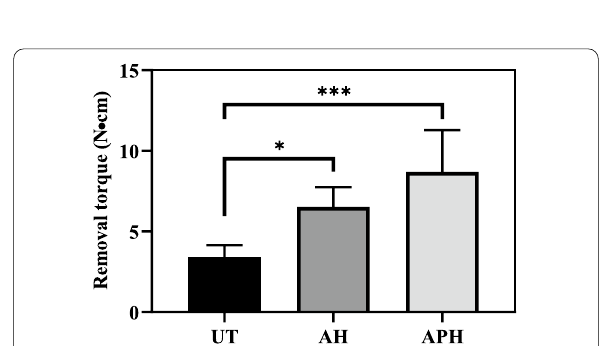
Fig. 8 Mini‑screw removal torque values were measured 4weks after implantation into rabbit tibias. The values were statistically analyzed by one‑way ANOVA followed by Tukey’s multiple comparisons test. The results are presented as the means (* denotes a p value of < 0.05; *** denotes a p value of <